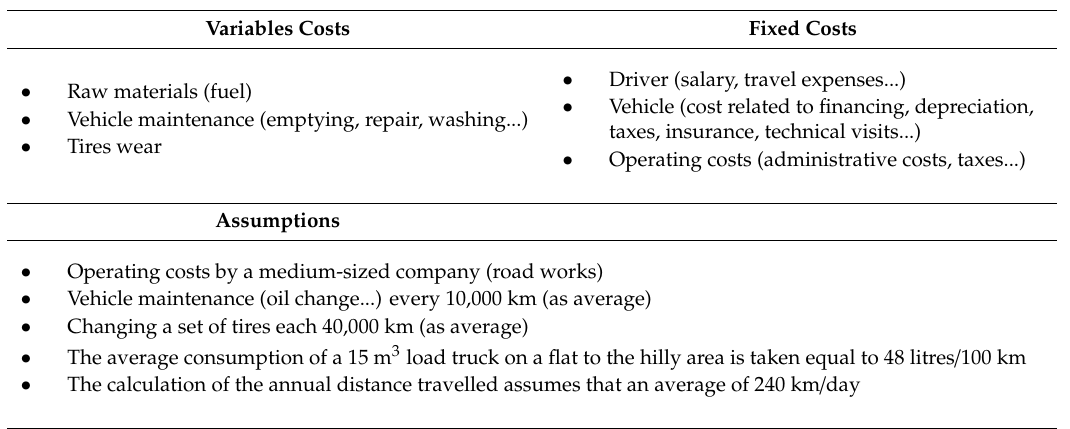
Table 8. Variable and fixed costs for transporting road